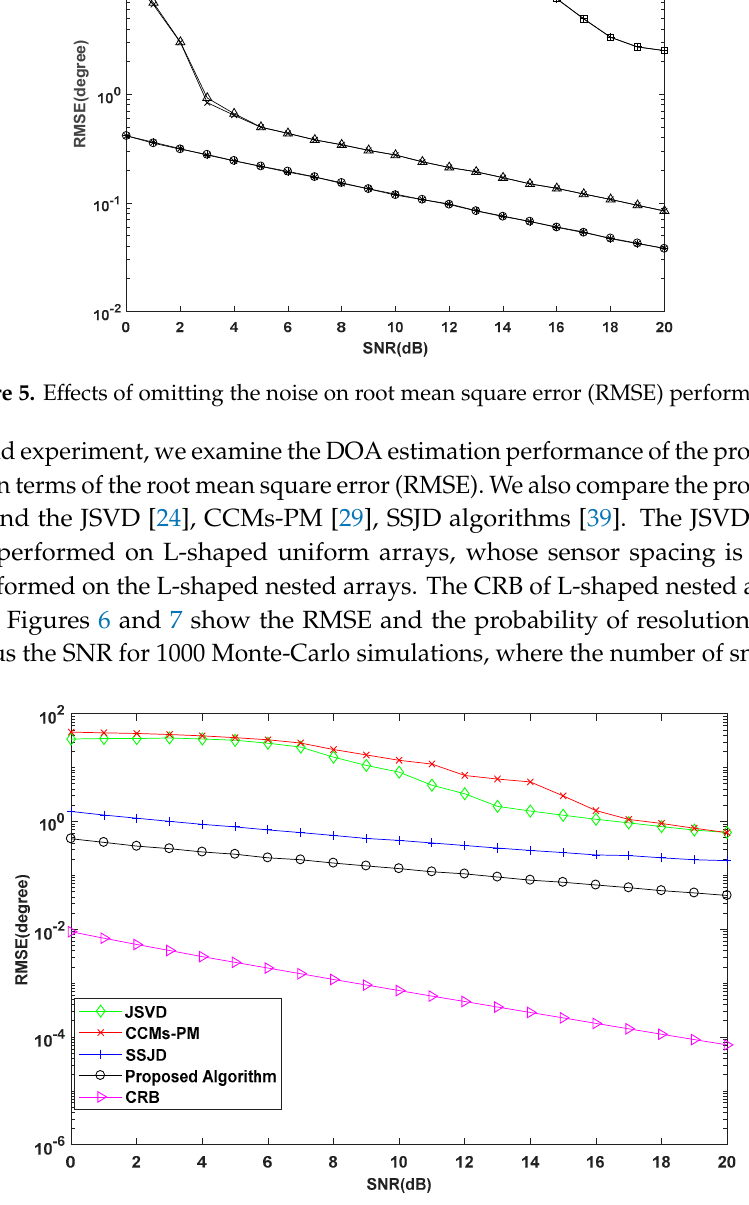
Figure 7. Probability of Resolution versus SNR for simulation with 100 snapshots. As shown in Figure 6, the RMSE of the proposed algorithm is lower than other compared algorithms for all SNRs. From Figure 7, we see the probability of resolution for all algorithms is improved with the increase of SNR, and the probability of resolution for the proposed algorithm is constant equal to 100%, which is obviously better than other compared algorithms. These results confirm that our proposed algorithm outperforms the JSVD algorithm and CCMs-PM algorithm due to the larger DOF obtained from nested arrays. Moreover, the computational complexity of the proposed algorithm is not higher than the JSVD algorithm and CCMs-PM algorithm. Compared with the SSJD algorithm, our algorithm also has better angle estimation performance by utilizing the reconstructed CCM instead of the ACM, which removes the noise vector. In the third experiment, we evaluate the DOA estimation performance of the proposed algorithm versus the number of snapshots. The SNR is set to 10 dB and 20 dB. The number of snapshots varies from 20 to 200. Similarly, we compare the performance of the proposed algorithm with CRB, and the JSVD, CCMs-PM, and SSJD algorithms with 1000 Monte Carlo trials.